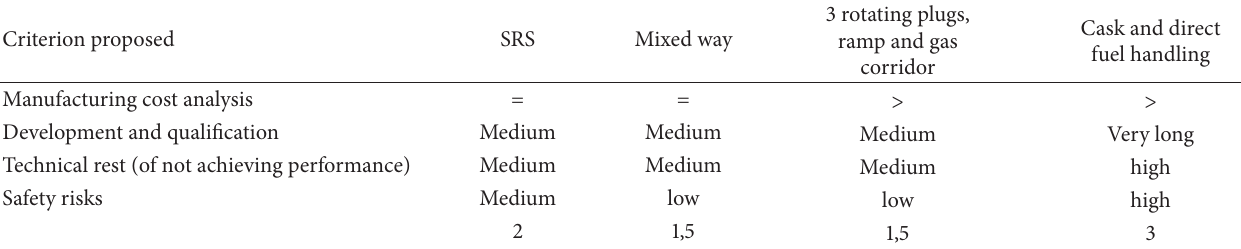
Table 2: Cost and risks aspects of the three FHR compared to the SRS option. Criterion proposed Manufacturing cost